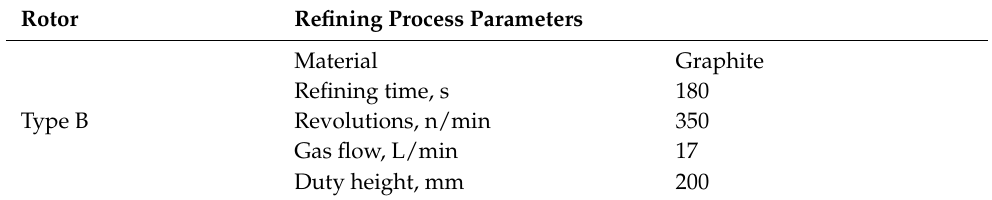
Table 5. Type C rotor—setting of refining technological